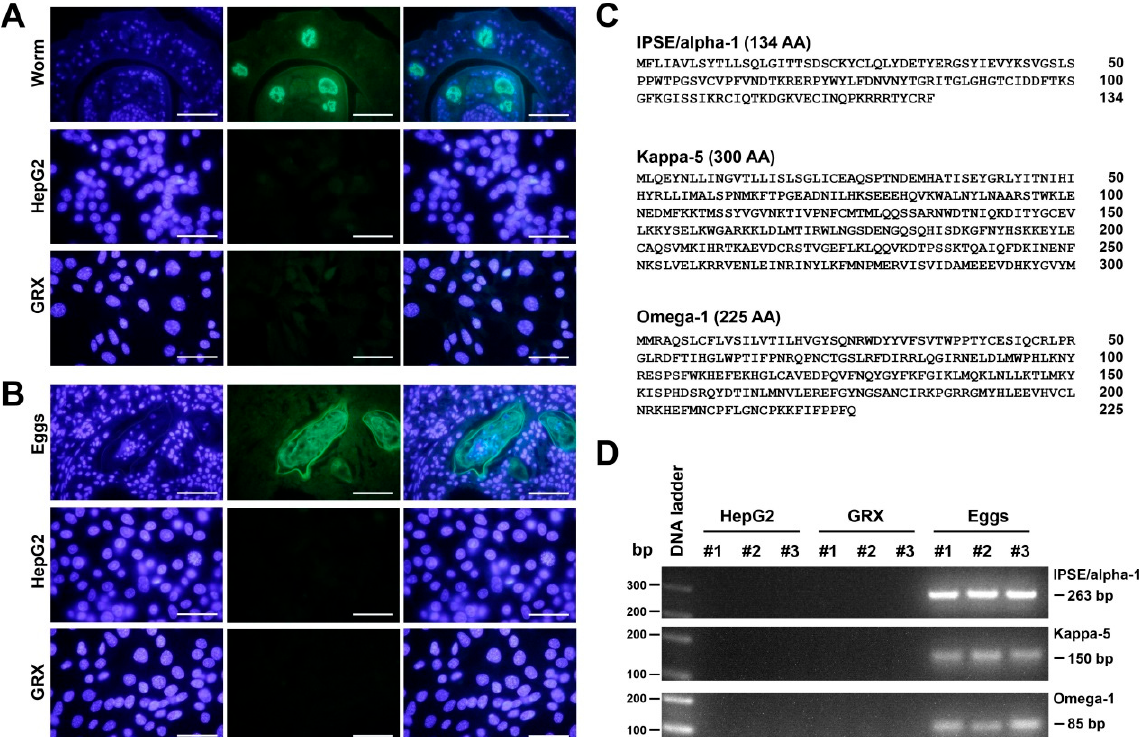
Figure 9. Analysis of potential S. mansoni -specific glycostructures in GRX cells. ( A ) The monoclonal antibody 54-4C2 produced against the schistosome gut-associated circulating anodic antigens (CAA) [50] was used to stain GRX cells (lower panel). HepG2 cells served as negative control (middle panel), while sections of the gut of the adult worm were used as a positive control (upper panel). ( B ) The glycan-binding monoclonal antibody 128-1E7 that binds with high affinity to a broad range of proteins containing cercarial O- and GSL-glycans and to a selection of cercarial N -glycans that all contain abundantly fucosylated glycans [51] was used to stain GRX cells. Although this antibody failed to recognize any epitopes on GRX (lower panel) and HepG2 (middle panel), the antibody-stained antigens that are expressed on the eggs in hepatic granuloma of bisex-infected mice (upper panel). Original magnifications in ( A , B ) are 1000 × . The scale bars correspond to 50 µ m. ( C ) Protein sequences of the major antigenic glycoproteins IPSE/alpha-1, Kappa-5 and Omega-1 from S. mansoni . Amino acid positions are given on the right margin. The protein sequences were taken from GenBank (https://www.ncbi.nlm.nih.gov/genbank/) entries deposited under access. nos. XM_018799269.1, AY903306.1, and DQ013207 (accession date: 15 April 2022). ( D ) RNA from HepG2 cells, GRX cells, and from S. mansoni -infected mouse liver was subjected to RT-qPCR. Specific amplicons for IPSE/alpha-1, Kappa-5 and Omega-1 were only produced from S. mansoni infected mouse liver. Primer combinations used for this analysis are given in the Material and Method section (see Section